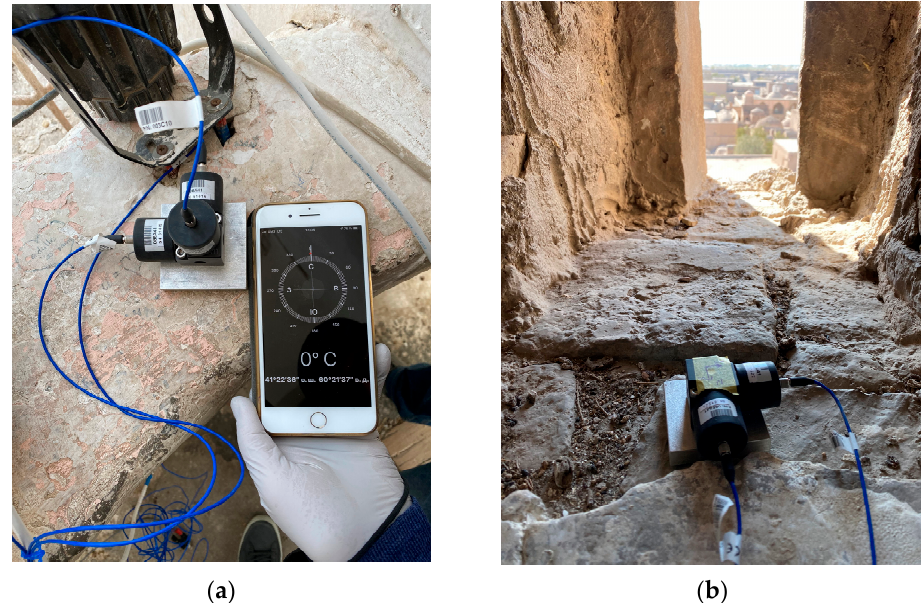
Figure 14. Sets of accelerometers installed at two elevations of minaret: ( a ) top window; ( b ) two- accelerometer set, in a window at mid-level.